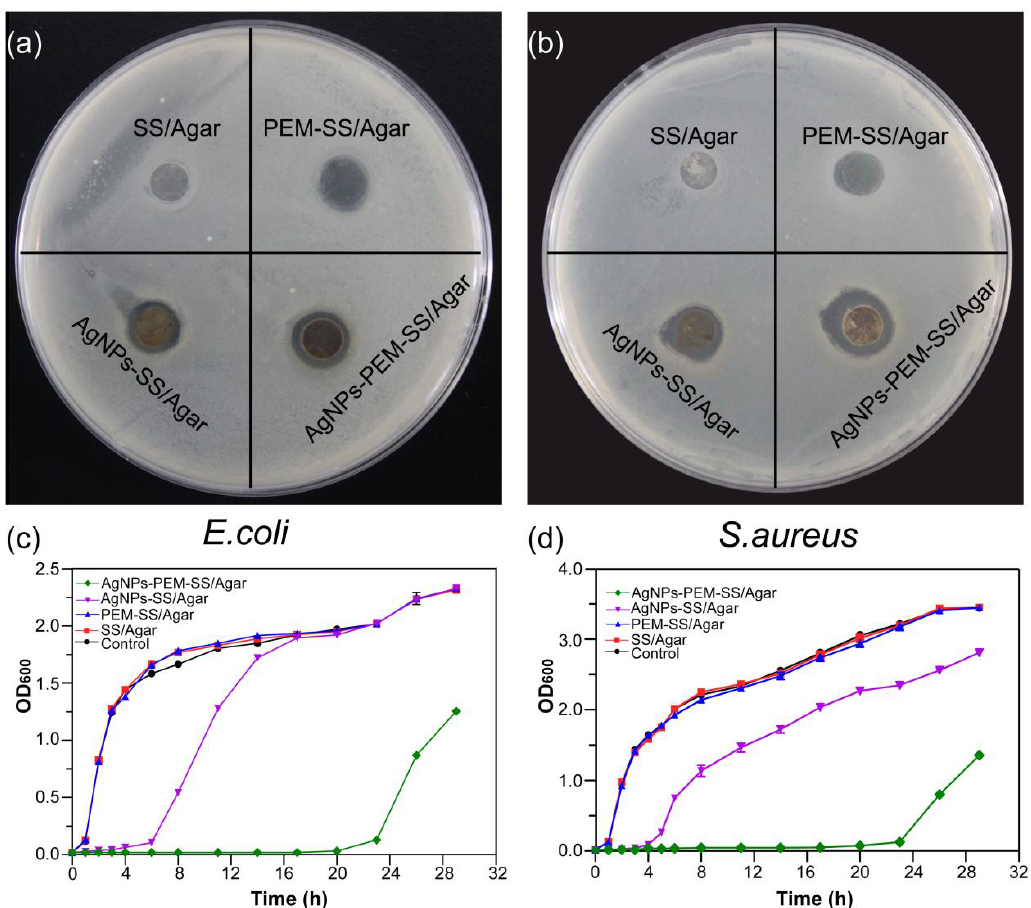
Figure 7. The inhibition zones of SS/Agar, PEM ‐ SS/Agar, AgNPs ‐ SS/Agar, AgNPs ‐ PEM ‐ SS/Agar films against E. coli ( a ) and S. aureus ( b ); Growth curves of E. coli ( c ) and S. aureus ( d ). Table 1. Diameters of the inhibition zones of SS/Agar, PEM ‐ SS/Agar, AgNPs ‐ SS/Agar and AgNPs ‐